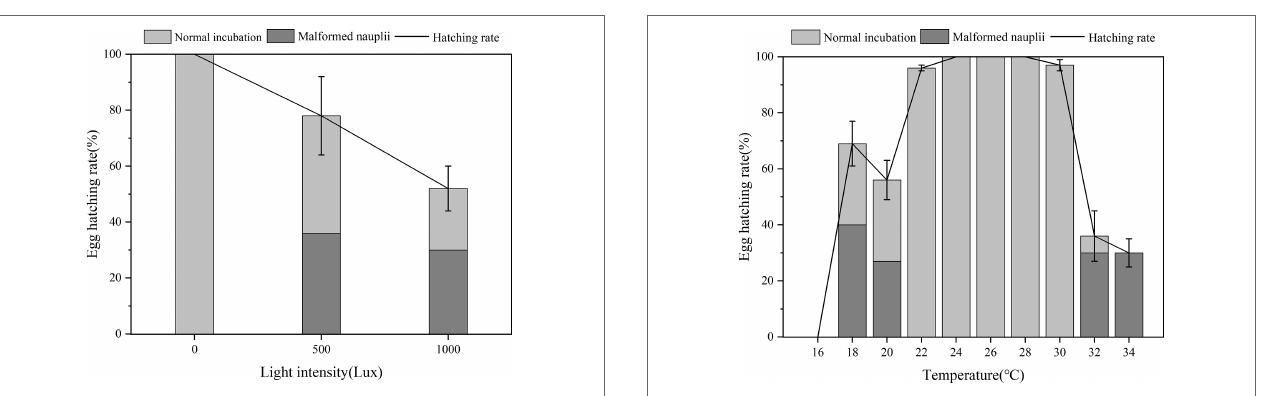
FIGURE 5 | Egg hatching rate of B. amoyensis incubated at different temperatures(N=45). Data are presented as mean± standard error (SE).